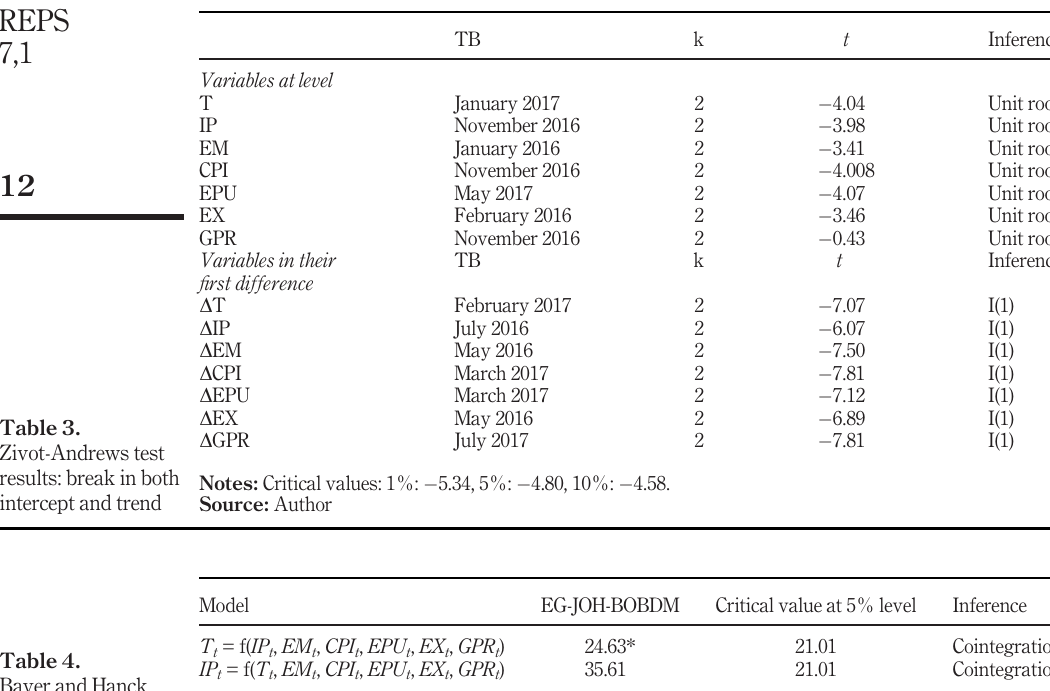
Model EG-JOH-BOBDM